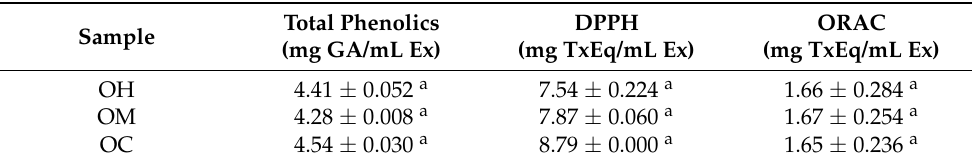
Table 2. Determination of total phenols and antioxidant capacity (ORAC and DPPH) of Mexican oregano extracts from different regions of Jalisco state.